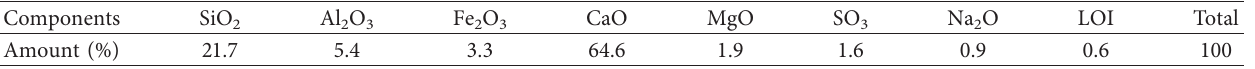
Table 1: Chemical components of cement.